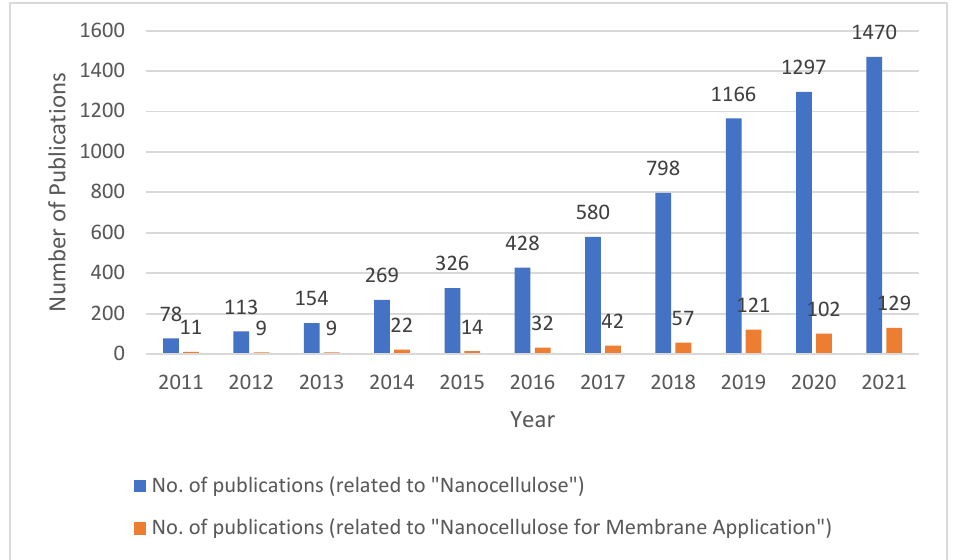
Figure 1. The number of publications (by year) in which the expressions “nanocellulose” and “nanocellulose + membrane” were seen in the title, keywords, or abstract in the last 10 years. These data were obtained from the database scopus.com (24 February 2022).